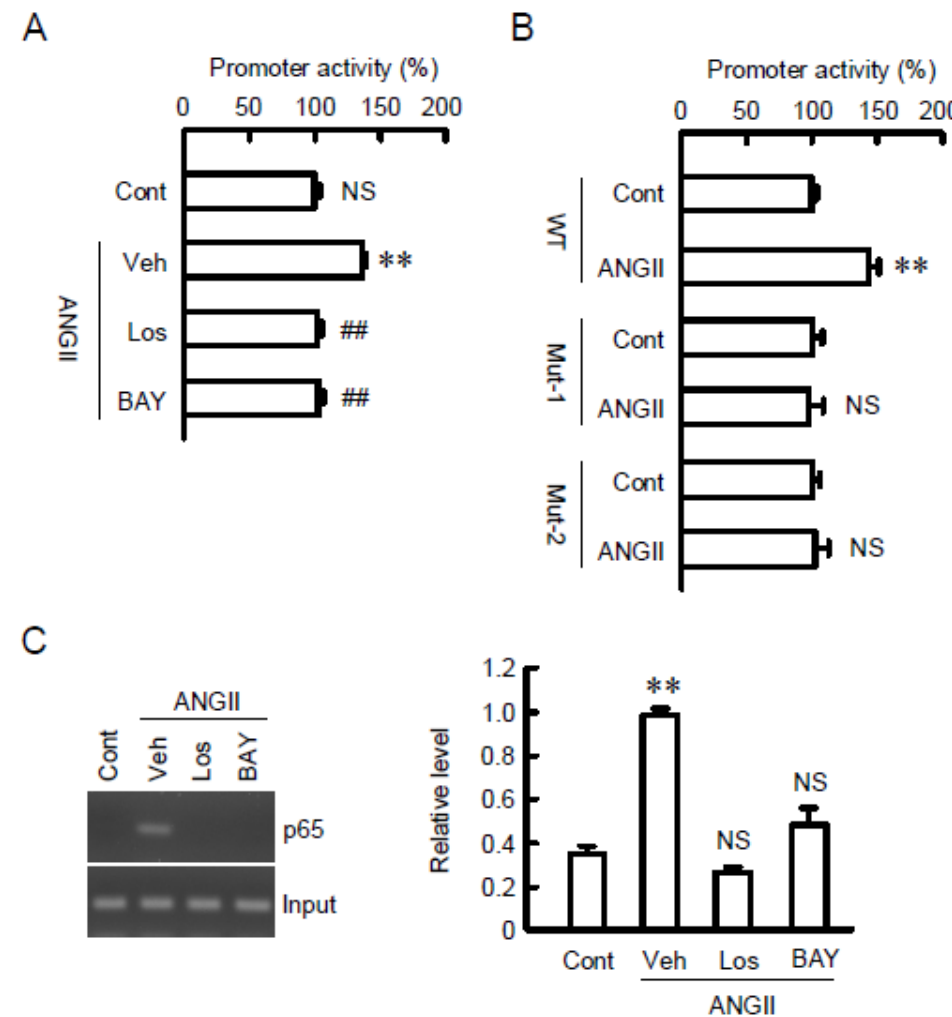
Figure 7. Binding of p65 to CLDN7 promoter by ANGII. ( A ) Promoter luciferase constructs of wild-type (WT) CLDN7 were co-transfected with pRL-TK vector into the cells. After 40 h of transfection, the cells were incubated in the presence and absence of 10 µ M ANGII, 10 µ M losartan (Los), and 10 µ M BAY for additional 8 h. Control cells (Cont) were not treated with these drugs. Vehicle (Veh) was treated with dimethylsulfoxide. The relative promoter activity was represented as the values of control (Cont). ( B ) Promoter luciferase constructs of WT, mutant-1 (Mut-1), and mutant-2 (Mut-2) were co-transfected with pRL-TK vector into the cells. After 40 h of transfection, the cells were incubated in the presence and absence of 10 µ M ANGII for additional 8 h. The relative promoter activity was represented as the values of control. ( C ) Nuclear proteins were prepared from the cells treated with 10 µ M ANGII for 1 h in the presence and absence of 10 µ M losartan (Los) or 10 µ M BAY. After immunoprecipitation of genomic DNA by anti-p65 antibody, semi-quantitative PCR was performed using the primer pairs amplifying the p65 binding sites (-648 / -635 and -616 / -603) of CLDN7 promoter. Input chromatin was used for loading control. ** p < 0.01 significantly di ff erent from Cont. NS p > 0.05 not significantly di ff erent from